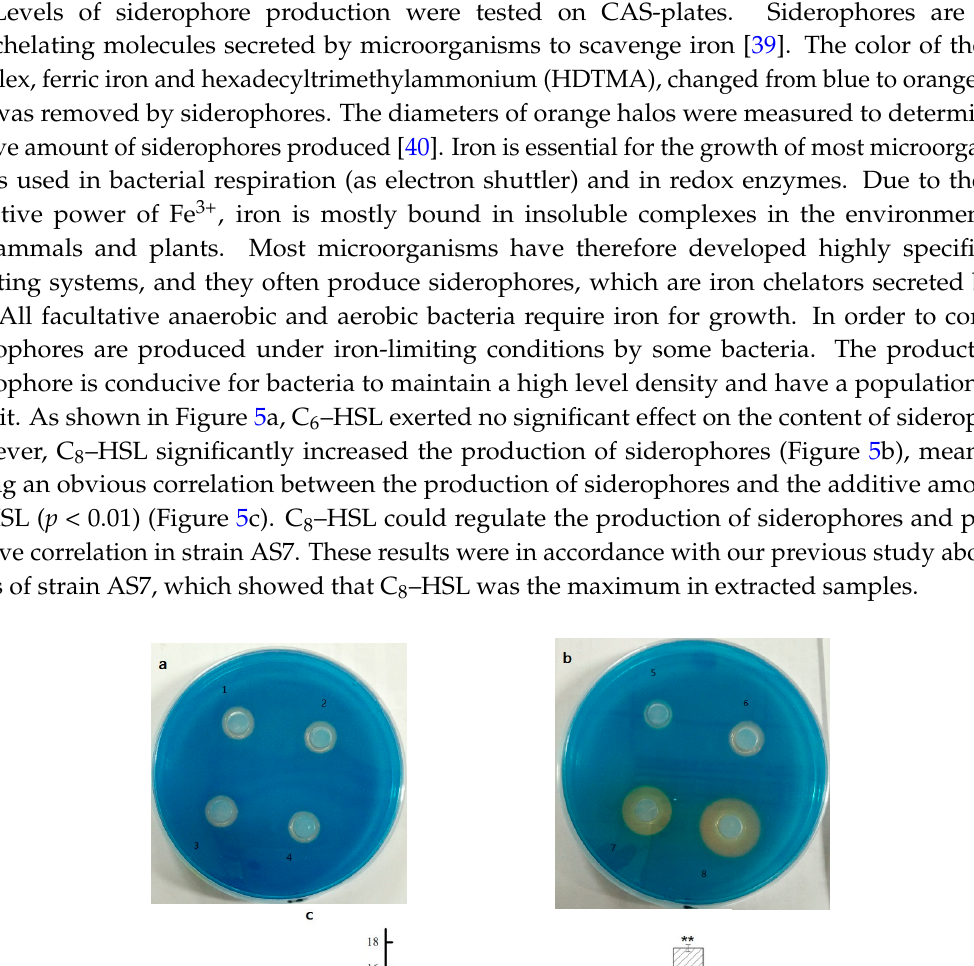
Table 2. The SIM parameter of six kinds of AHLs.